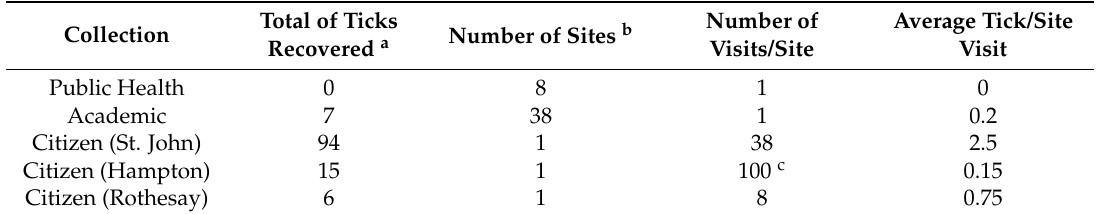
Table 2. Comparison of effectiveness of tick recovery per site visit by different groups performing tick surveillance in the same area during the same time period.